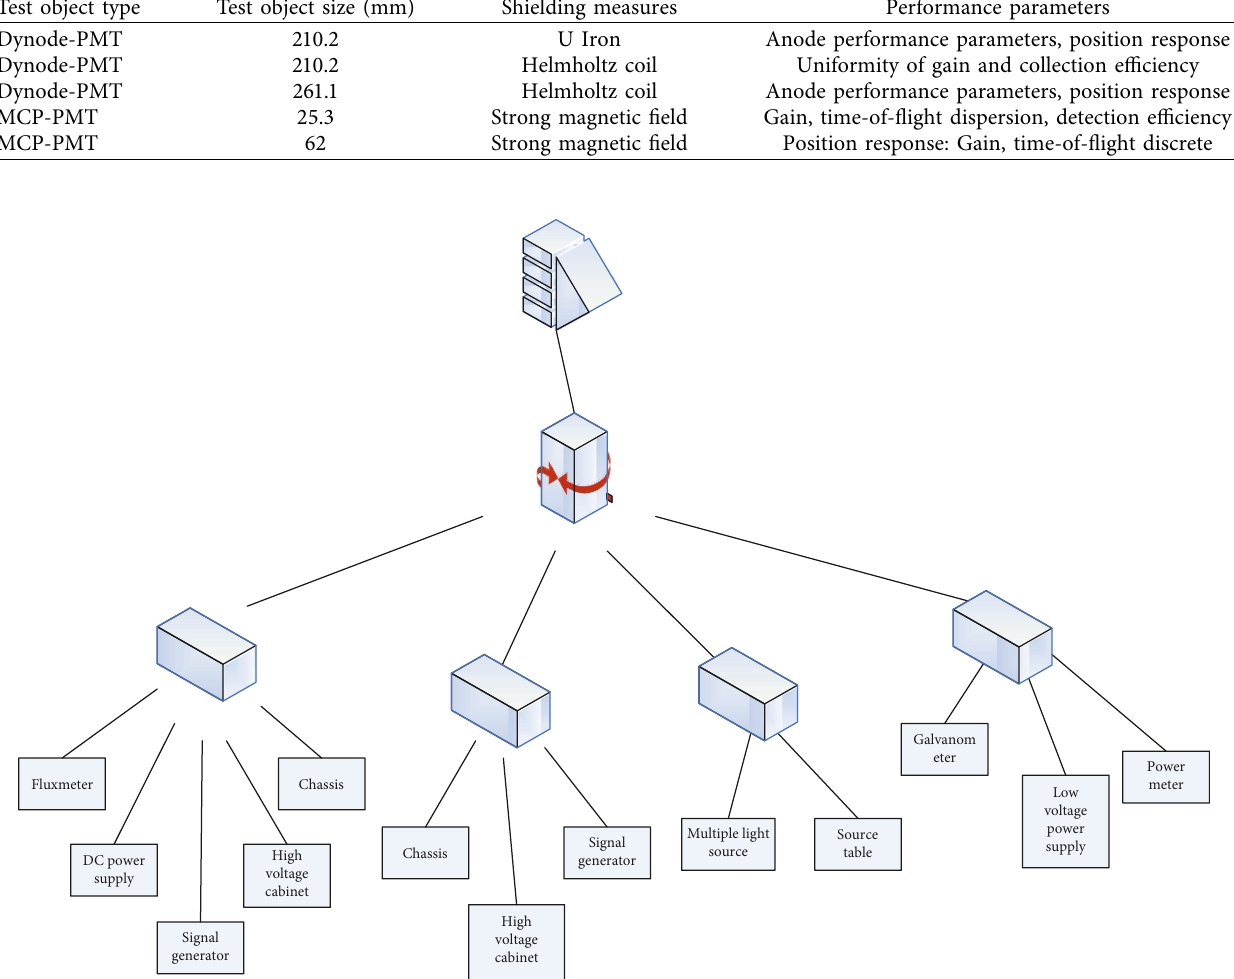
Figure 1: Overall structure diagram of the test